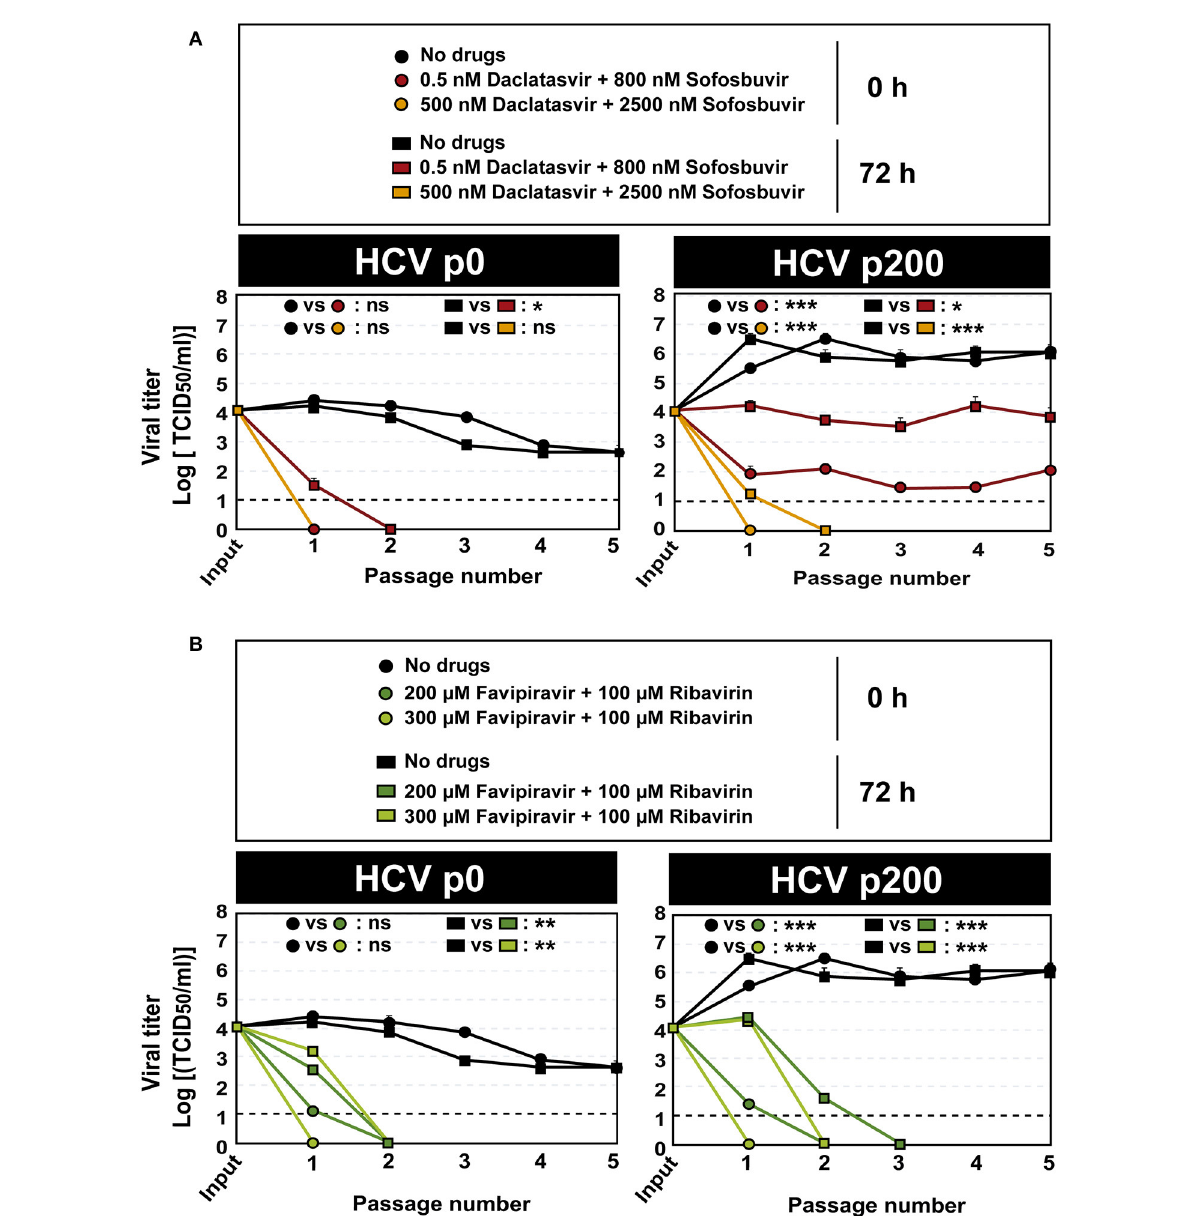
FIGURE4 Extinction of HCV populations by serial passages in the presence of antiviral agent combinations. (A) The responses of HCV p0 and HCV p200 subjected to five serial infections in the absence or presence of the daclatasvir and sofosbuvir are indicated in the box. (B) The responses of HCV p0 and HCV p200 subjected to five serial infections in the absence or presence of the favipiravir and ribavirin are indicated in the box. The initial and the viruses at passage 1 are those described in Figure 3. The time of infection and of addition of the antiviral inhibitors are indicated; in all cases, virus titer in the cell culture supernatant was determined 72h after addition of the inhibitors. The differences between the viral titers along the passages as given at the top of each graph are as follows: ns: no significant; * p < 0.05; ** p < 0.01; *** p < 0.001; ANCOVA test. Viral titer values can be found in Supplemental Table S4. Extracellular RNA values can be found in Supplemental Table S5 and Supplementary Figure S3. Experiments were performed in triplicate (replicas A, B, and C in Supplemental Tables S4, S5). Procedures followed for drug preparation, cell infections, and titration of infectivity are detailed in Materials and